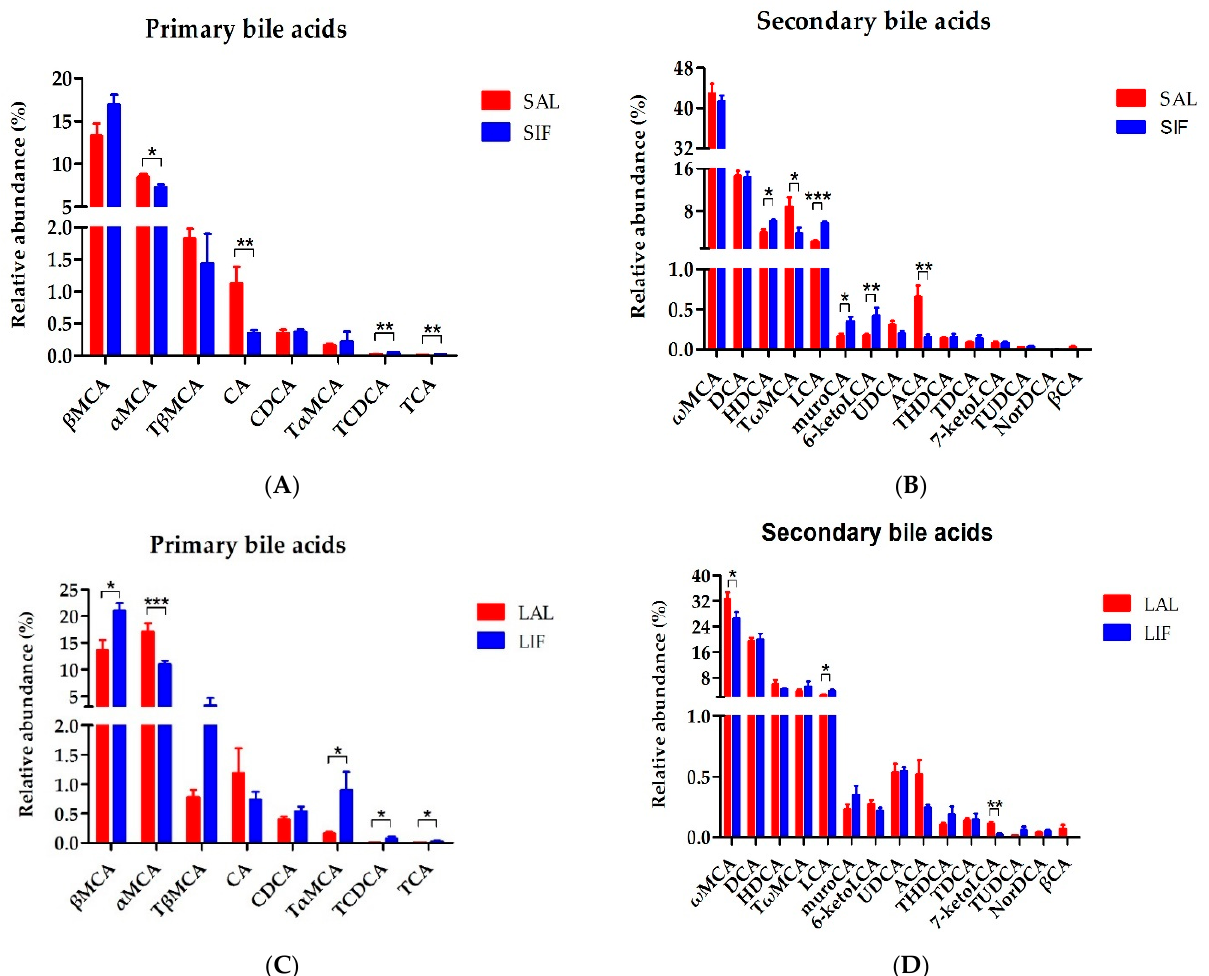
Figure 3. Bile acid profile of faeces after IF : ( A ) primary bile acids in the faeces with short-term IF; ( B ) secondary bile acids in the faeces with short-term IF; ( C ) primary bile acids in the faeces with long-term IF; and ( D ) secondary bile acids in the faeces with long-term IF. SAL: Short-term of ad libitum-fed group; SIF: Short-term of intermittent fasting group; LAL: Long-term of ad libitum-fed group; LIF: Long-term of intermittent fasting group. * p < 0.05, ** p < 0.01, *** p < 0.001.